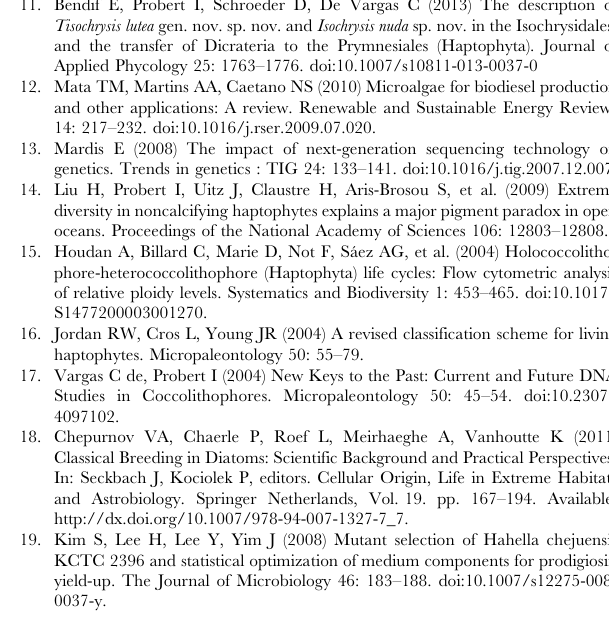
Figure S1 Enzymes of lipid pathways identified in universal KEGG. Each enzyme with a colour corresponds to a transcript annotated in KEEG. Figure A corresponds at lipid synthesis and Figure B catabolism of lipid. Figure S2 Comparison of G + C content in transcrip- tomes of Tiso and reference microalgae. Colour code: green for chlorophytes, red for rhodophyte, orange for glauco- phyte, blue for dinoflagellate, yellow for diatoms and purple for haptophytes.